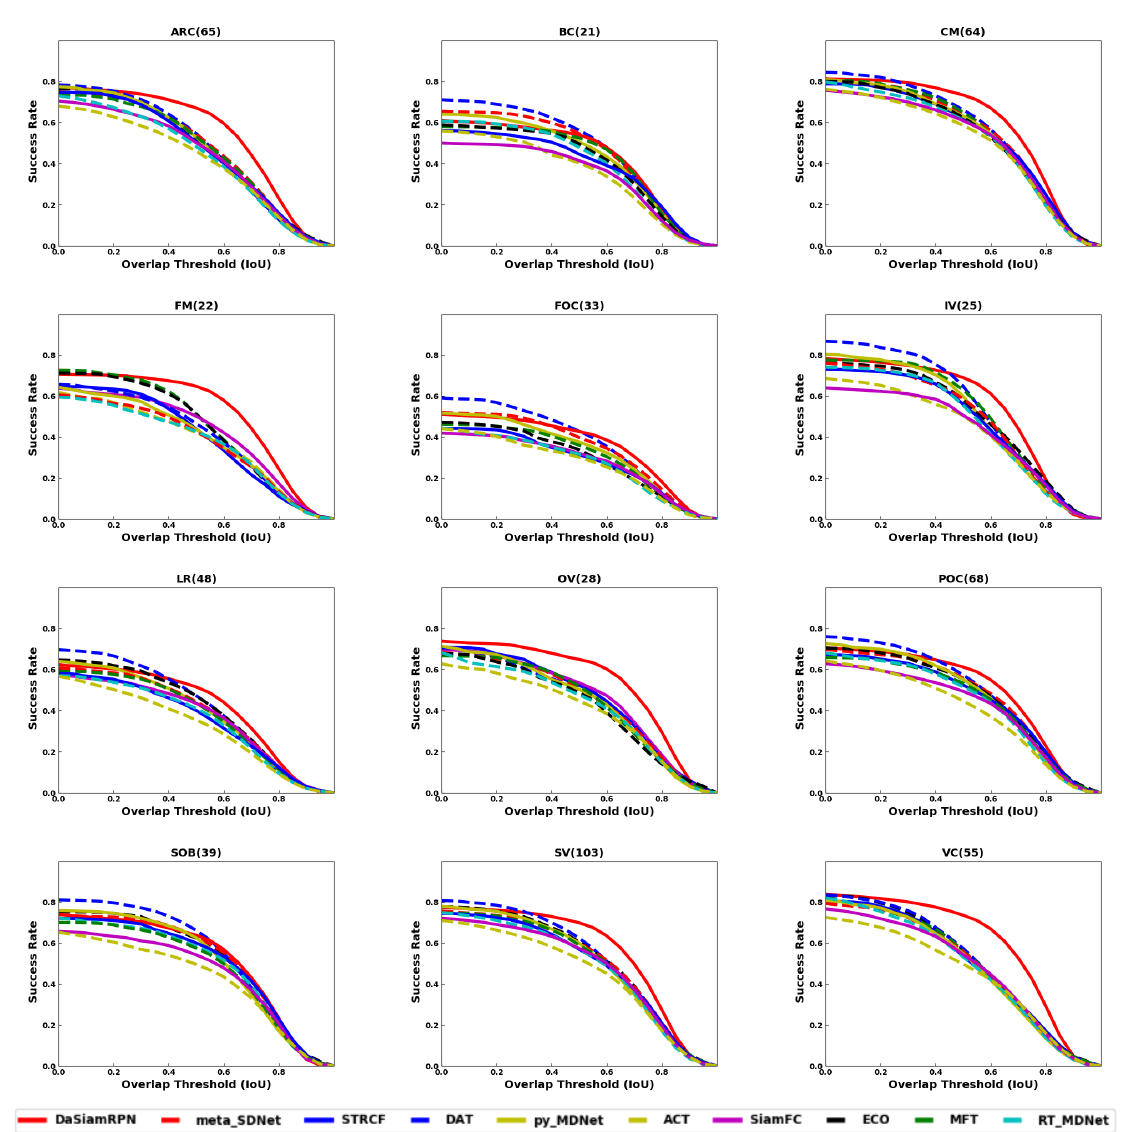
Figure 6. Overlap plots of OPE for UAV123 dataset attributes. DaSiamRPN outperforms other trackers in most of the challenges except BC, FOC, and SOB. Best viewed in